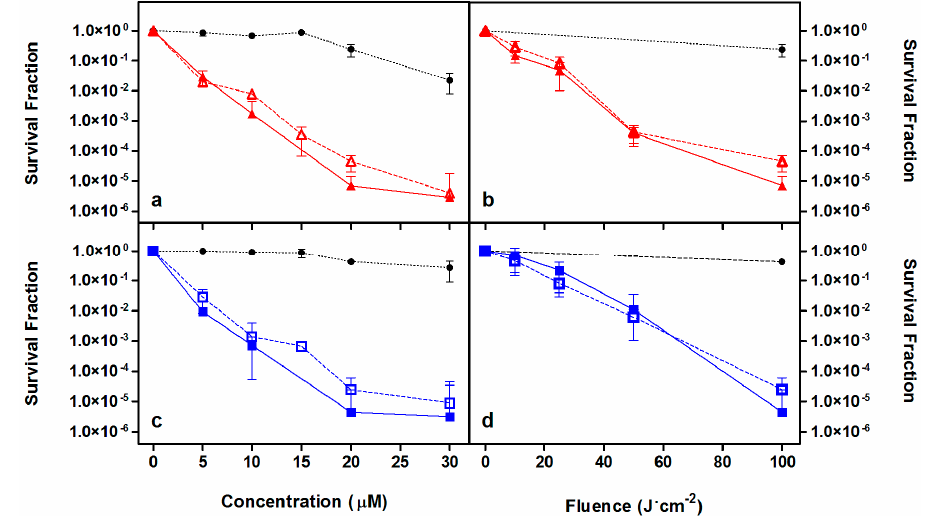
Figure 5. Photoinactivation studies against P. aeruginosa . Porphycenes 1 (red, a , b ) and 2 (blue, c , d ) survival curves removing (empty symbol) or not (filled symbol) the PS excess from the solution before irradiation. Black symbols are the controls. Solid and dashed lines connecting data series are provided for visualization purposes. Fluence was maintained at 100 J·cm − 2 ( a , c ) and PS concentration of 20 μ M was assayed ( b , d ).